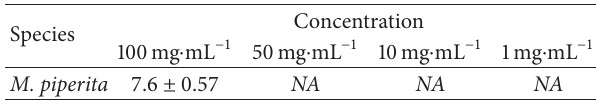
Table 4: Measurement results of the inhibition halos (mm) of the essential oil of M. piperita against strains of Staphylococcus aureus .